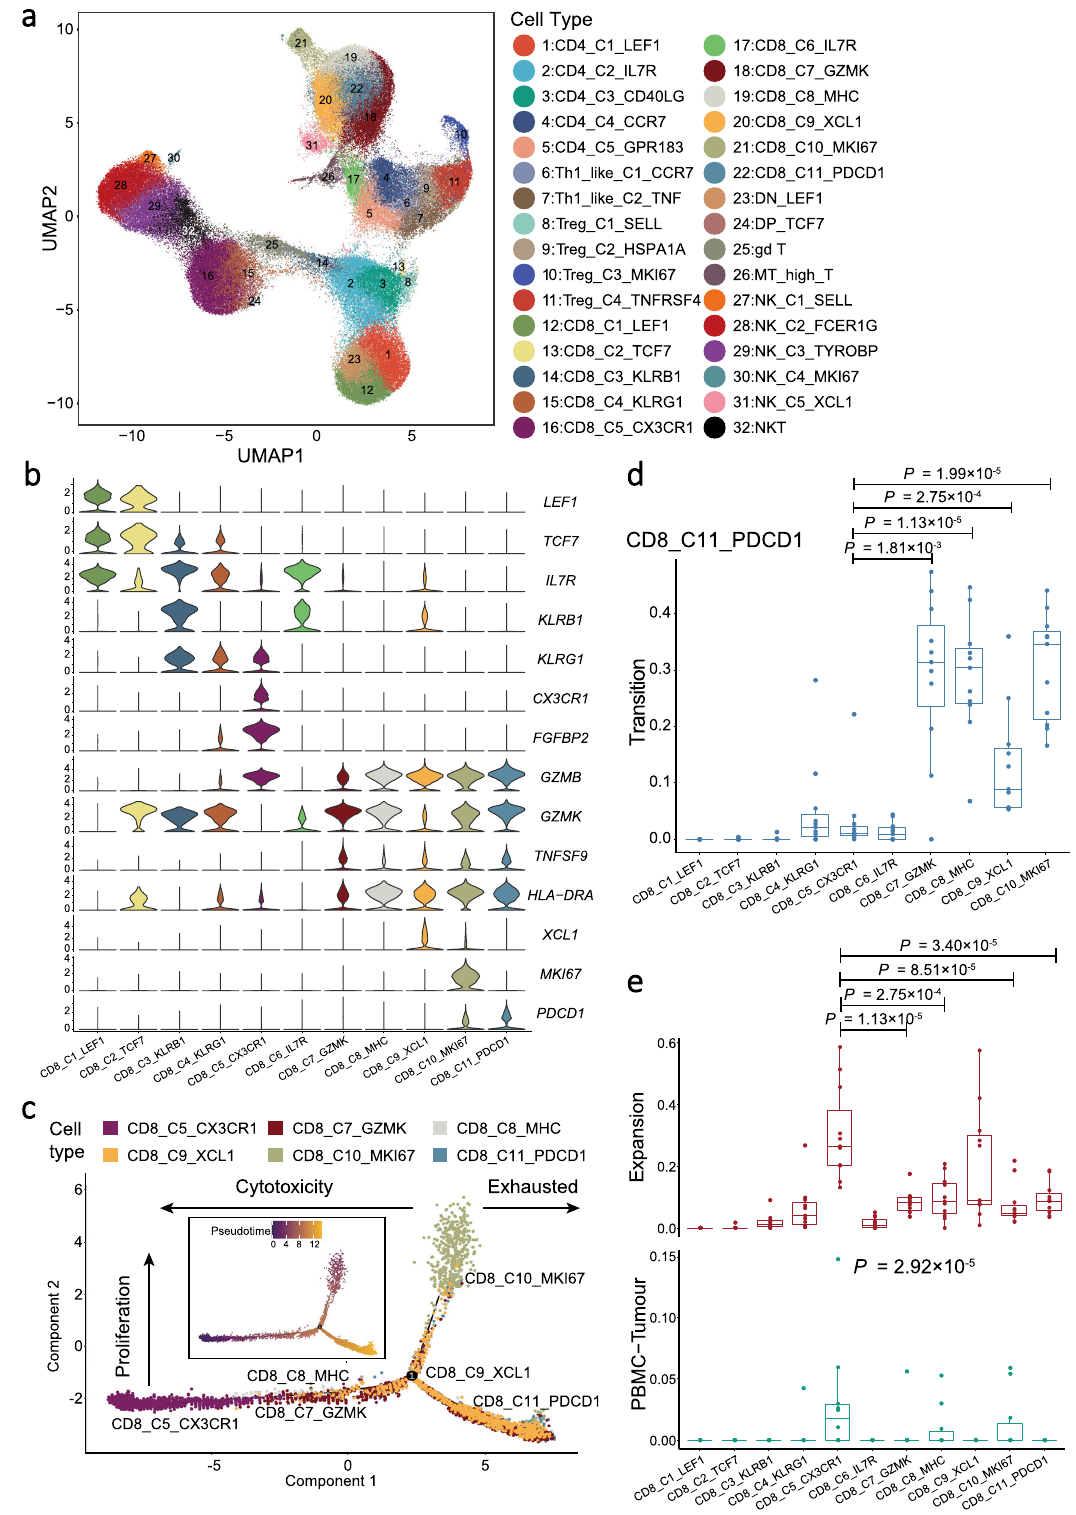
clusters of CD4 + Th1-like cells in tumours, including Th1_li- ke_C1_CCR7 and Th1_like_C2_TNF, with speci fi c expression of naïve T cell markers and pro-in fl ammatory cytokines, respec- tively, as well as a common expression of Th1-like cell markers 21 ( CXCL13 , BHLHE40 , and CXCR3 ; Supplementary Fig. 2d). Next, we performed T cell receptor (TCR) repertoire analysis based on the sequences of α and β chains of TCR, which revealed